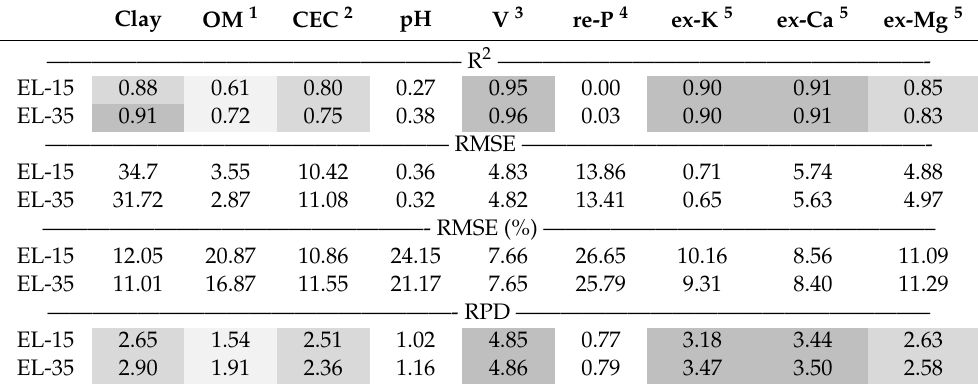
Table 3. Prediction results of the validation set (n = 34) obtained from multiple linear regressions (MLR) models calibrated using a portable X-ray fluorescence (XRF) sensor configured with two di ff erent X-ray tube voltages of 15 and 35 kV, designated as EL-15 and EL-35,